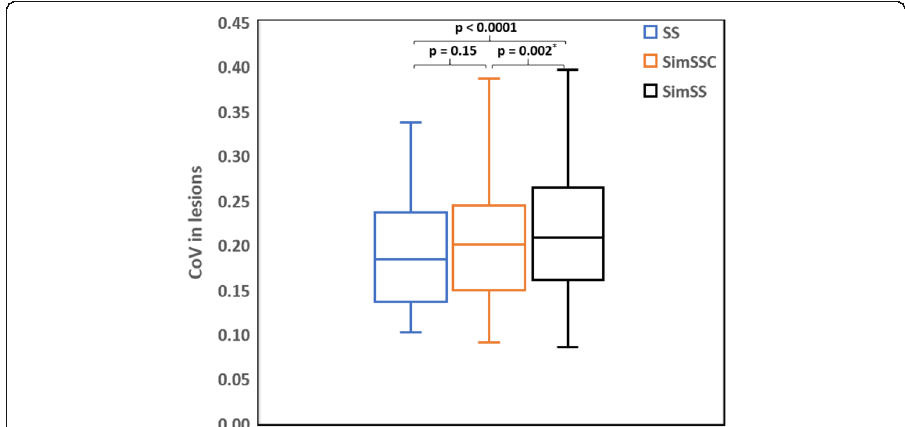
Fig. 7 Box plot showing the coefficient-of-variation of the 50 lesions, for three acquisition modes (SS, step- and-shoot; SimSSC, simulated step-and-shoot continuous; SimSS, simulated step-and-shoot). The median is illustrated by the midline, first and third quartiles by the lower and upper lines of the box, and extremes by